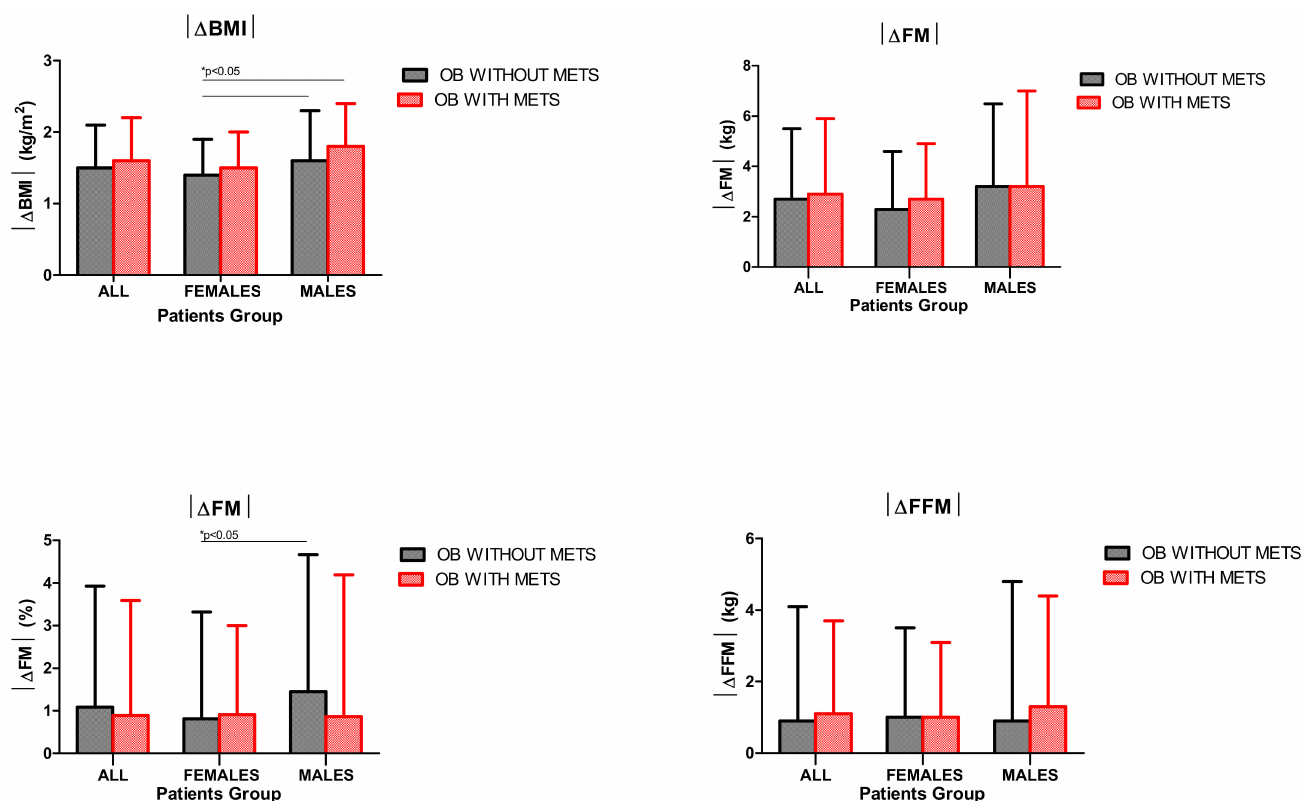
Figure 1. Absolute values of changes ( | ∆ | ) of body mass index ( | ∆ BMI | , top left panel), fat mass ( | ∆ FM | ) expressed as kg (top right panel), | ∆ FM | expressed as % (bottom left panel) and fat-free mass ( | ∆ FFM | , bottom right panel), before and after a three-week body weight reduction program (BWRP) in obese (OB) children and adolescents with or without metabolic syndrome (METS). Data are expressed as mean ± SD. The values corresponding to each sex-related subgroup (females / males) are reported. All parameters were compared among all subgroups (all, females / males, obese with / without metabolic syndrome) before and / or after the body weight reduction program (BWRP) by using a Wilcoxon signed-rank test (two groups) or a Kruskal–Wallis one-way ANOVA on ranks (more than two groups), when